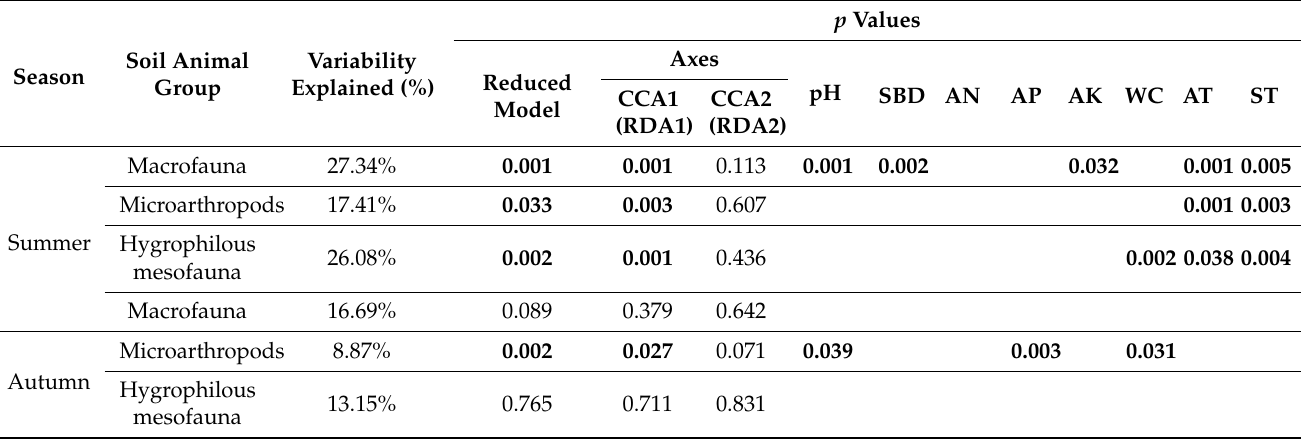
Table A6. Results of the canonical correspondence analysis (CCA) and redundancy analysis (RDA) of soil fauna. Significant values are marked in